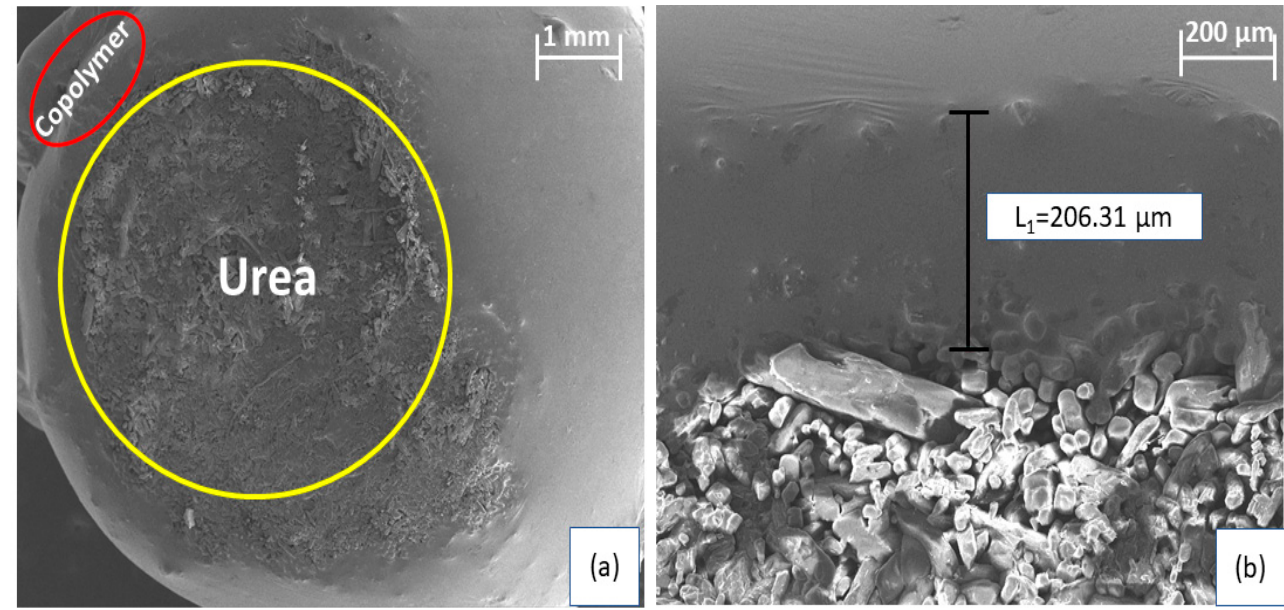
Figure 7. SEM images of the cross-section of the coated urea. ( a ) 1 mm. ( b ) 200 µm